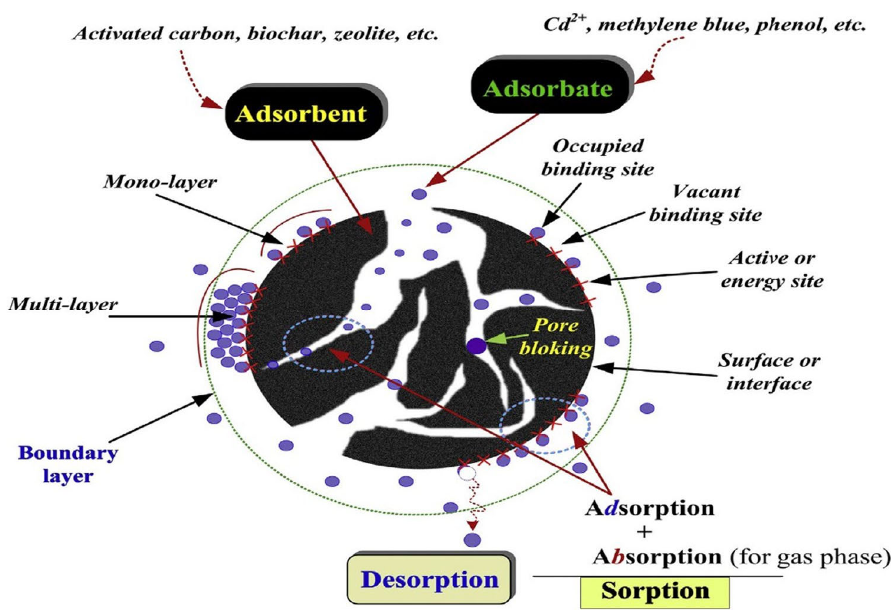
Figure 7. The adsorption fundamentals. Source: